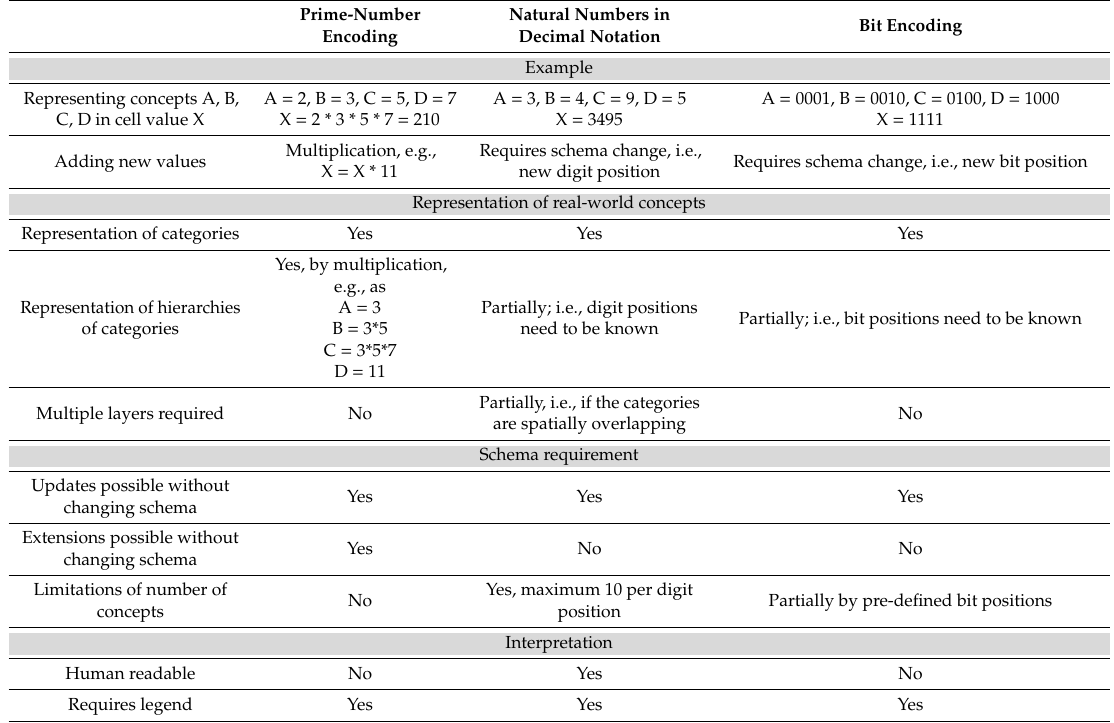
Table 1. Comparison of di ff erent encoding